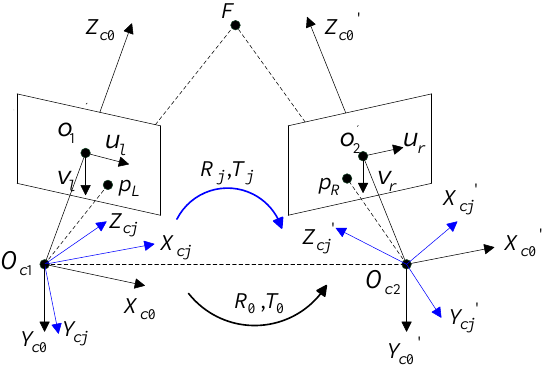
Figure 1. Mathematical model of binocular stereo vision.